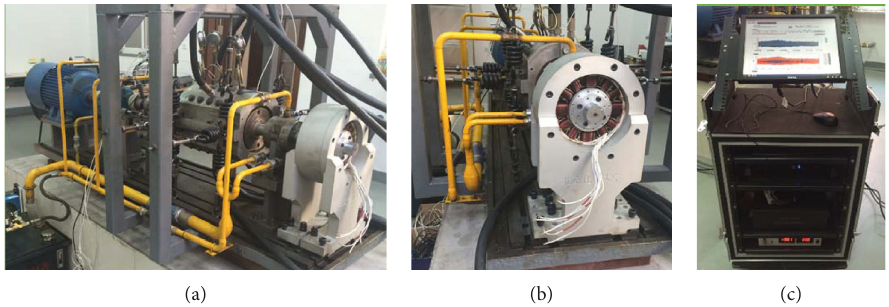
Figure 8: Rotor stability test rig. (a) The sealing performance testing platform for electromagnetic bearing exciter is installed. (b) Electromagnetic bearing exciter. (c) Several mining and control systems.